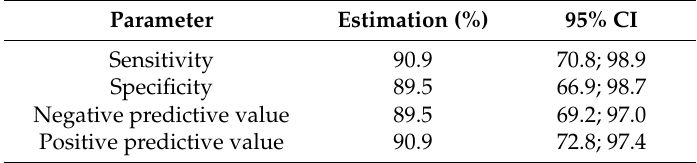
Table 4. Evaluation of the predictive rule for the outcome based on the score (threshold =